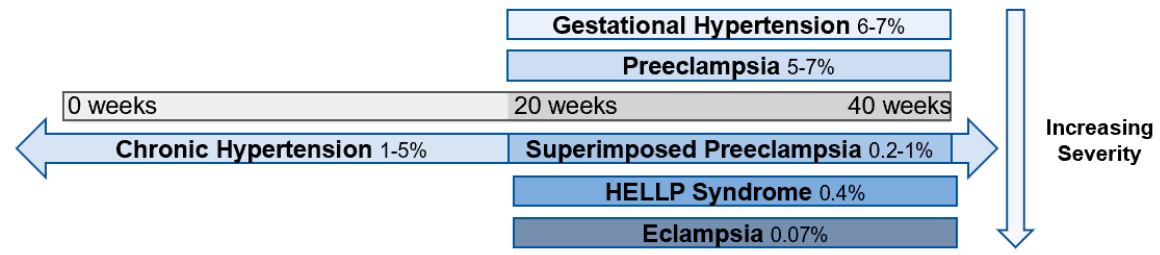
Figure 1. Spectrum of hypertensive disorders during pregnancy and their prevalence [9–11]. Gestational hypertension is defined by new-onset elevations in blood pressure (<140/90 mmHg) after 20 weeks of gestation, whereas preeclampsia is also accompanied by proteinuria and end-organ dysfunction. Chronic hypertension is present prior to 20 weeks of gestation or continues >12 weeks into the postnatal period and can occur in concert with preeclampsia. Hemolysis, elevated liver enzymes, and low platelets (HELLP) syndrome is classified as a subset of preeclampsia, and eclampsia is a complication of preeclampsia characterized by the addition of seizures.